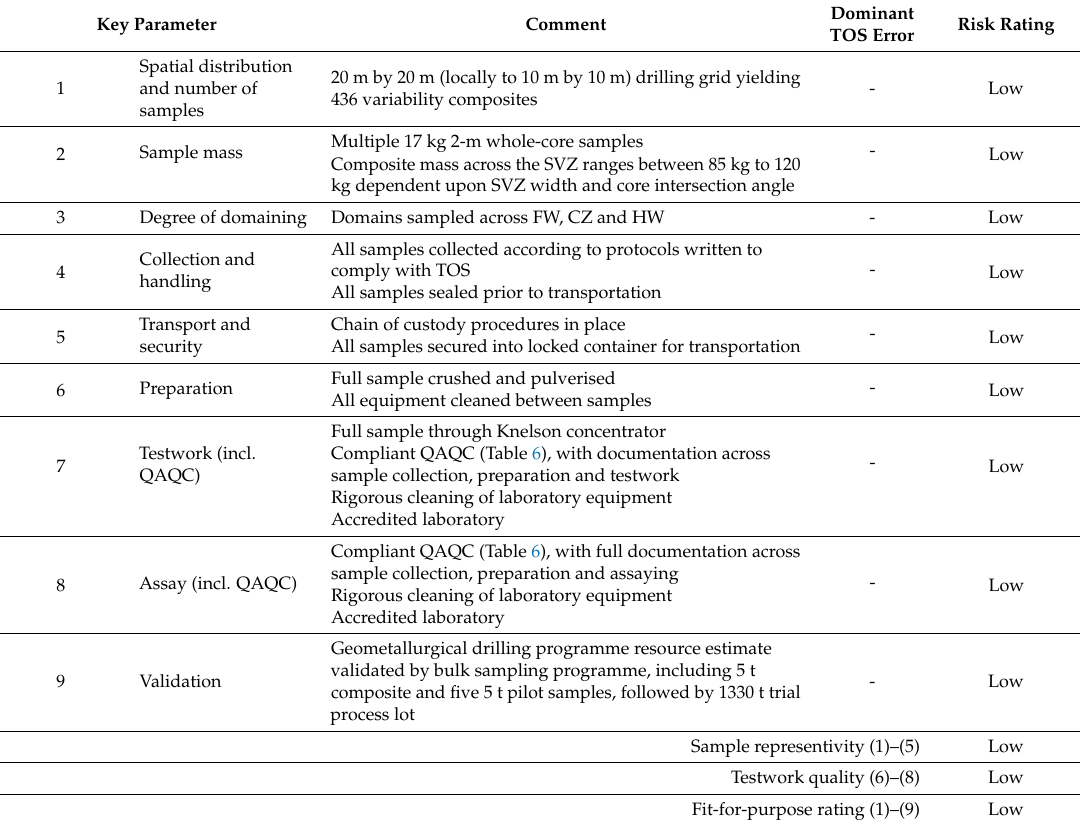
Table 7. Risk review of geometallurgical drilling programme sampling, testwork and assay, after [8].